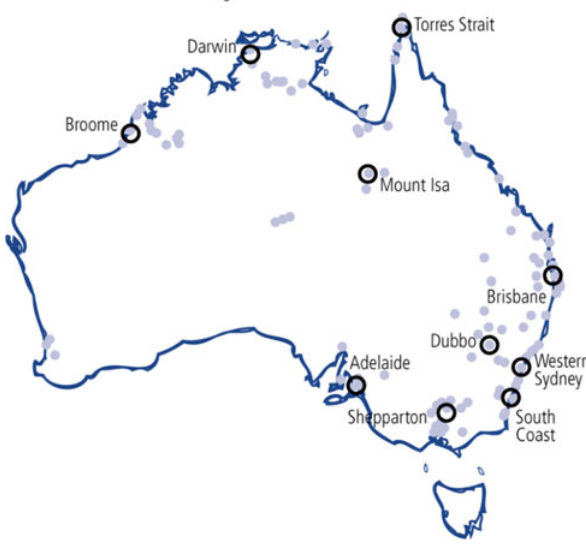
Fig. 1. Footprints in time interviewing locations (Kneebone et al ., 2012, p.